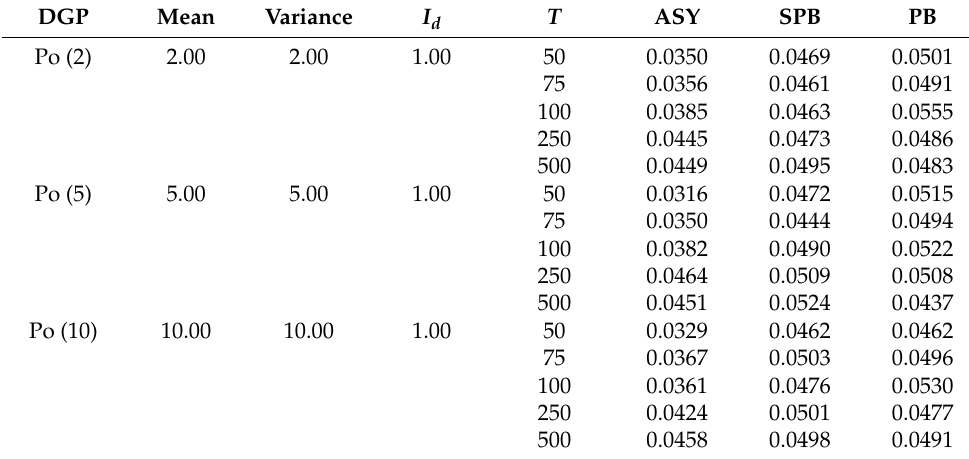
Table 1. Empirical size of the bootstrap-based score test under Poisson DGP. ASY: asymptotic, SPB: semiparametric bootstrap, PB: parametric bootstrap.